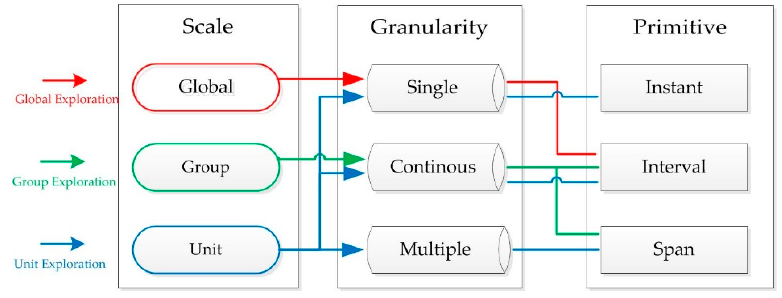
Figure 7. Spatiotemporal combination in OGVES.